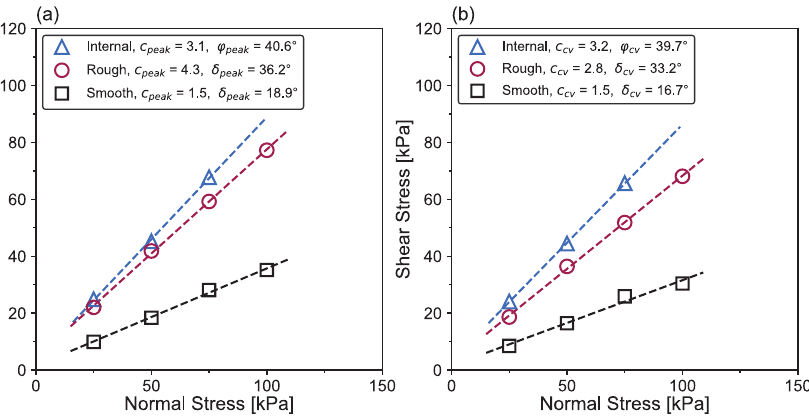
9 of 12 Figure 9. Vertical strain as a function of horizontal displacement from interface direct shear test on JEZ-1-steel plate: ( a ) smooth and ( b ) rough surfaces. All the tests on JEZ-1 simulant-steel interface for the two considered roughness are summarized in the Mohr plane in Figure 10 and compared with the results of soil-soil. The peak and residual adhesions (i.e., c peak and c cv ), as well as peak and residual interface friction angles (i.e., δ peak and δ cv ) are obtained from the linear envelopes in Figure 10. The c peak values of the smooth and rough interface are 1.5 kPa and 4.3 kPa, and the c cv values